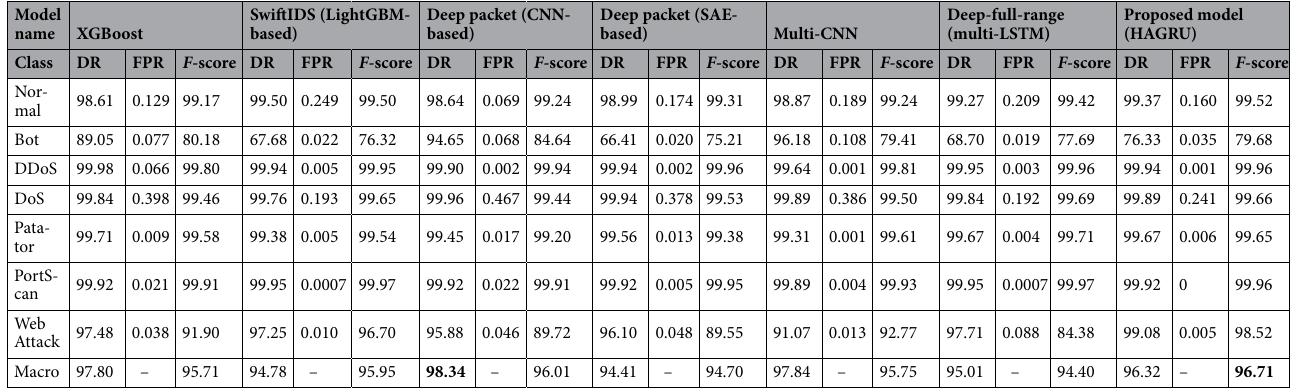
Table 5. Performance comparison of each model in CIC-IDS2017 dataset (units: %, bold indicates the best